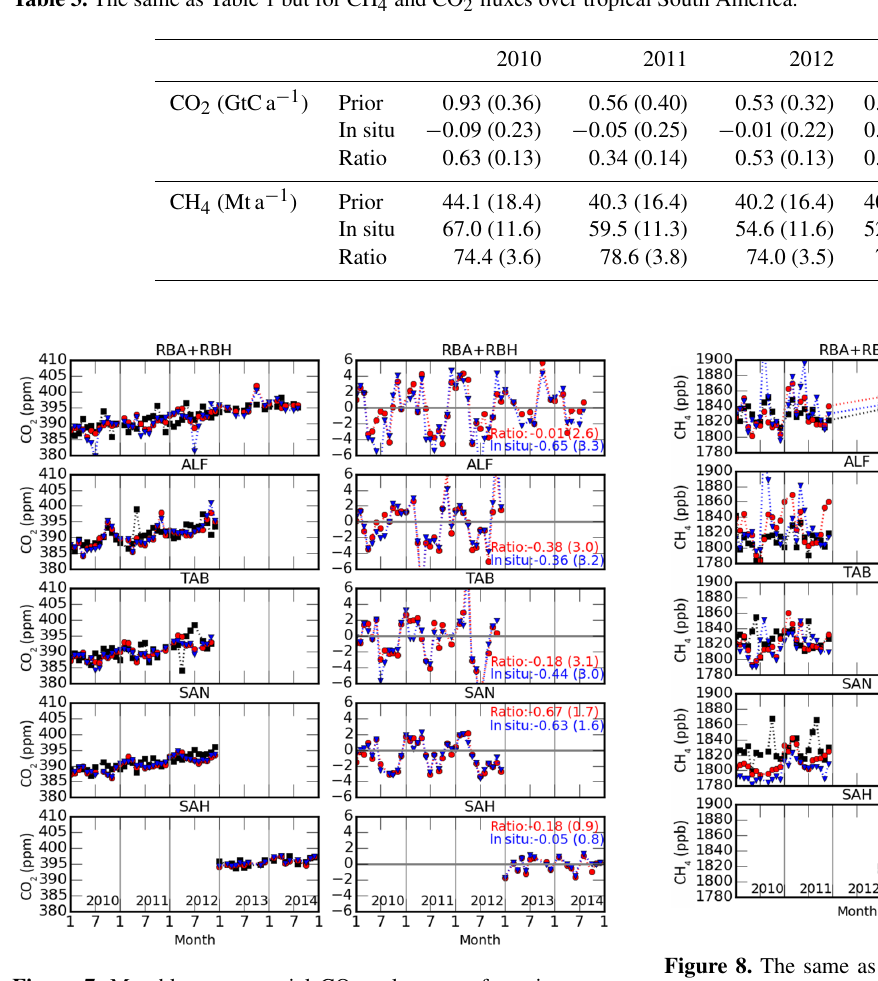
Figure 7. Monthly mean partial CO 2 columns at four sites over the Amazon (RBA, ALF, TAB, and SAN; Fig. 1) collected by the AMAZONICA project and two sites (RBH and SAH) after 2012 collected by the ACO project: comparison (left) and differences (right) with the GEOS-Chem model that has been sampled at the time and location of each observation and driven by fluxes inferred from the in situ (blue) and ratio (red) inversions. The mean and stan- dard deviations (ppm) are shown in the inset of the right-hand-side panels. In the plot, we have combined the data over the AMAZON- ICA site RBA (for 2010 to 2012) and the ACO site of RBH (for 2012 to 2014) for a complete time series from 2010 to 2014 over the same location.